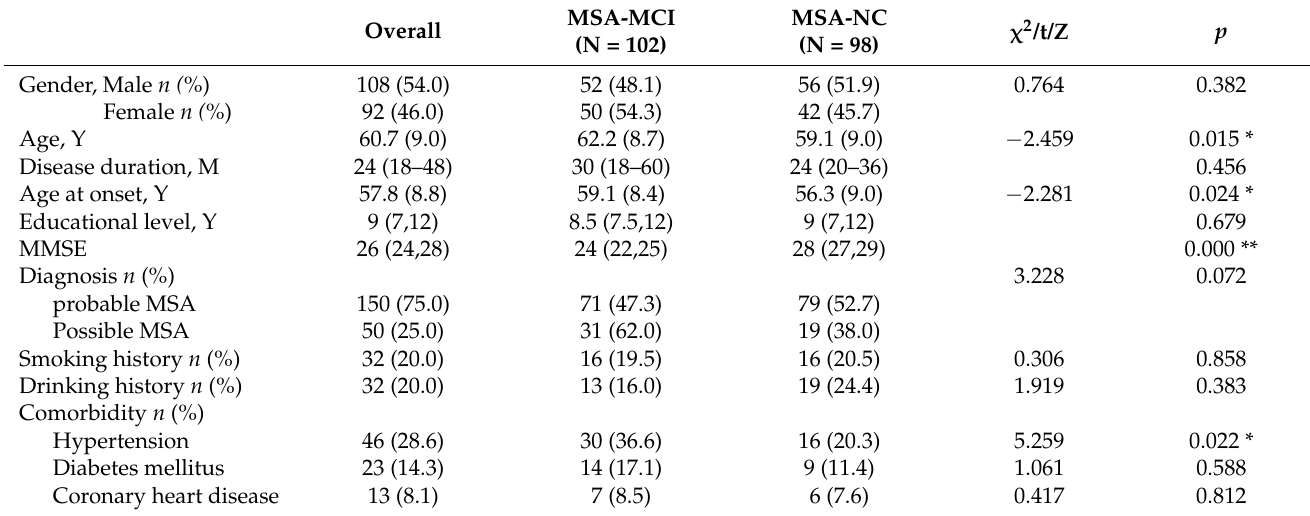
Table 1. Demographic characteristics in patients with MSA.